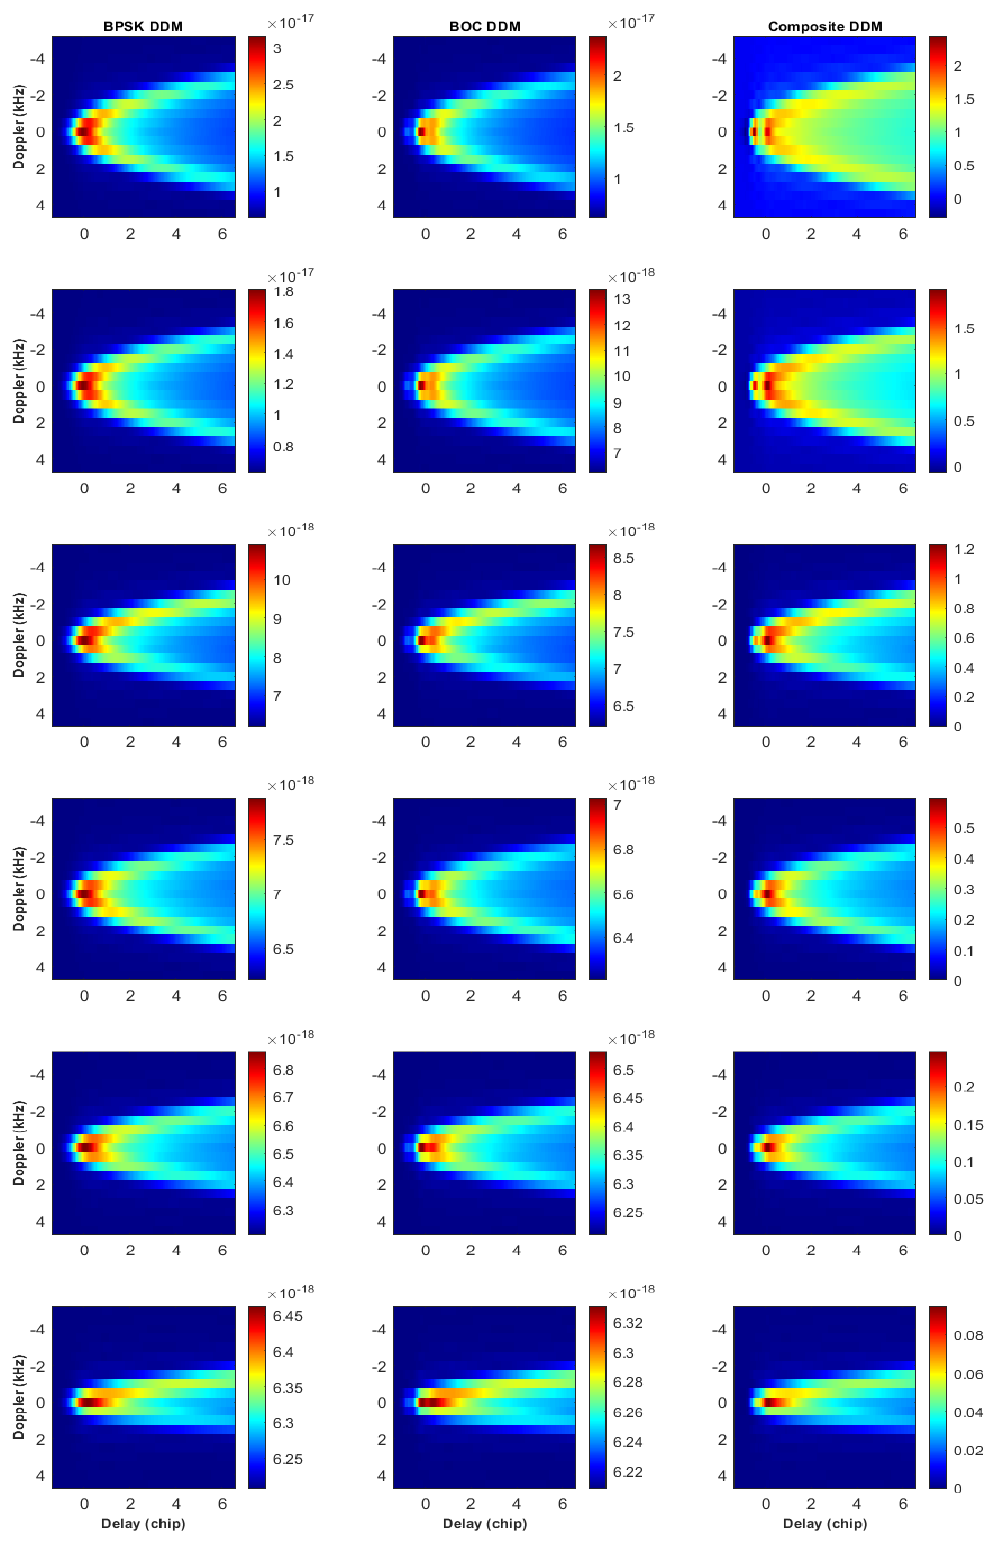
Figure 4. Examples of the binary phase-shift keying (BPSK)-DDM, binary offset carrier (BOC)-DDM, and the composite DDM (cDDM) for different wind speeds and incidence angles. The first, second, and third columns are BPSK-DDM, BOC-DDM, and cDDM, respectively. The specified parameters from the top row to bottom row are, respectively, 10/3, 20/5, 30/10, 40/15, 50/20, and 60/30 (incidence angle/wind speed).